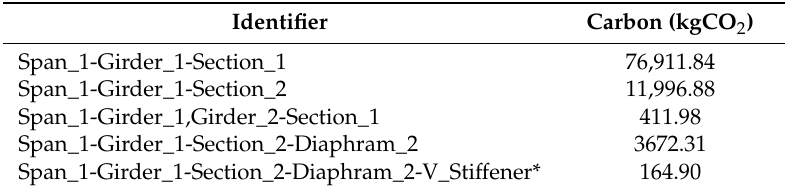
Table 7. Query responses of the estimated carbon emission based on the generated